Question: In one sentence, what is this figure communicating?
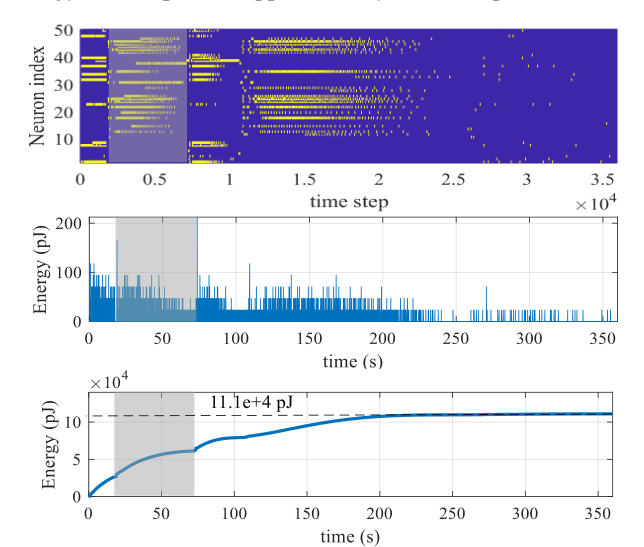
Answer: (a) Spiking pattern, (b) Energy consumed per time  step, and (c) Total energy consumption for satellite rendezvous  with a dynamic obstacle.